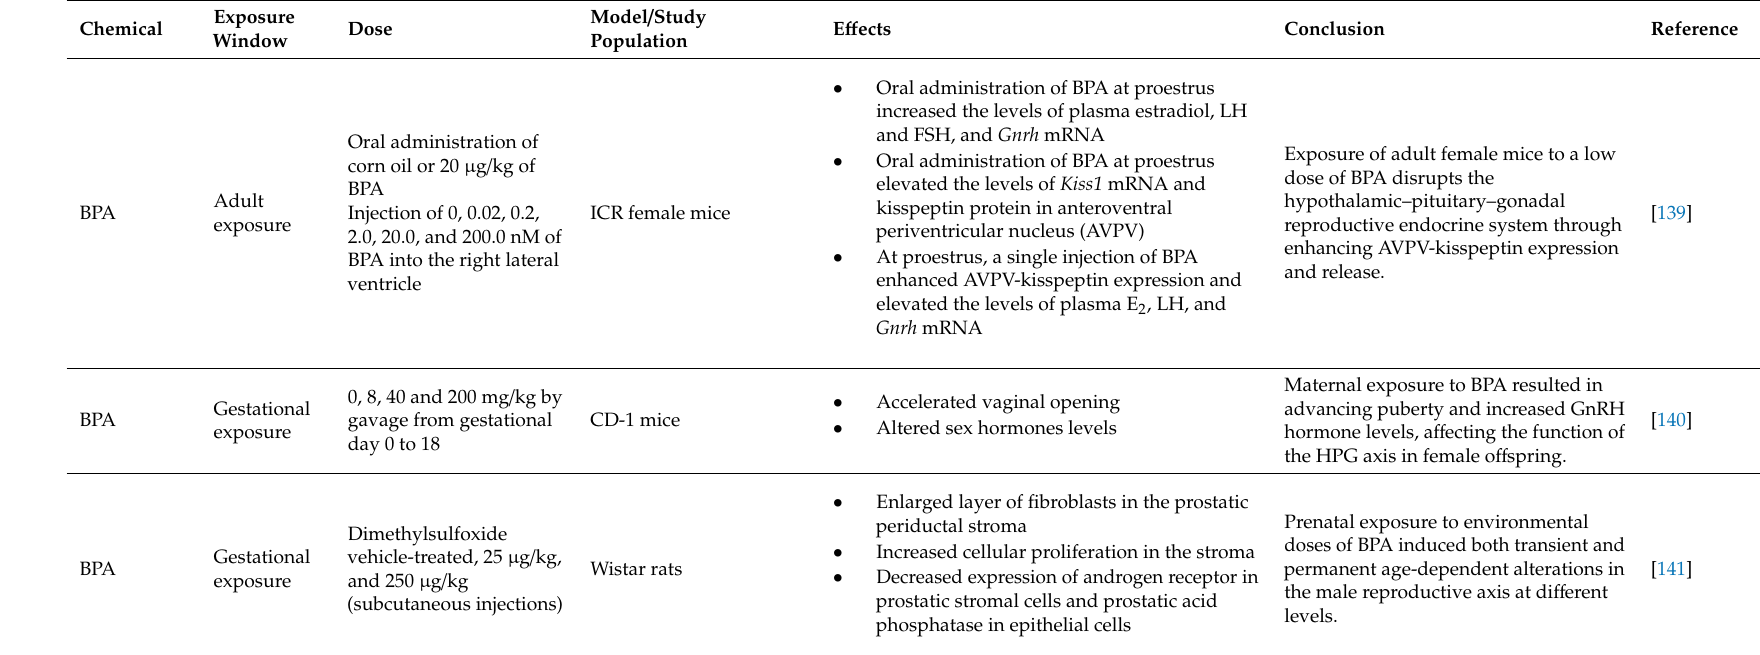
Table 5. E ff ects of BPA on the Reproductive